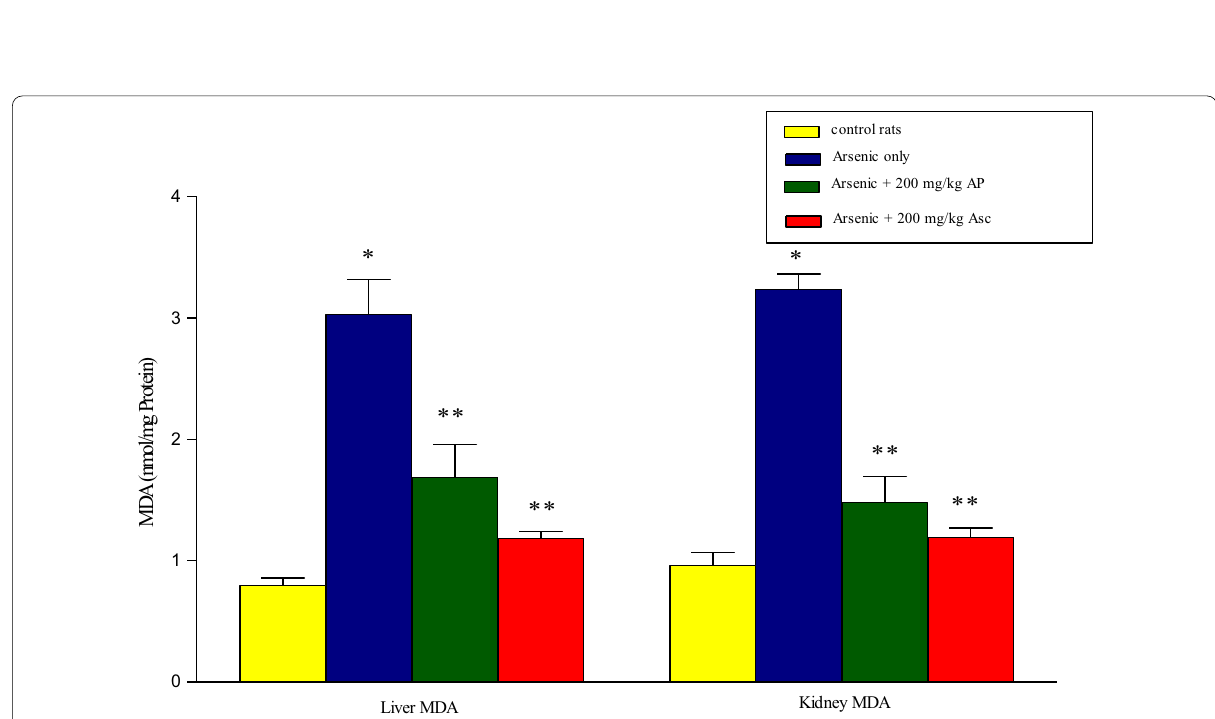
Fig. 4 Effect of methanolic extract of A. paniculata on hepatic and renal MDA levels in arsenic-induced rats. Values are mean *( p < 0.05) Group 2: (arsenic group rats) compared with group 1: (control rats). **( p < 0.05) Groups 3 and 4: ( A. paniculata or ascorbic acid administered rats, respectively) compared with group 2: (arsenic group